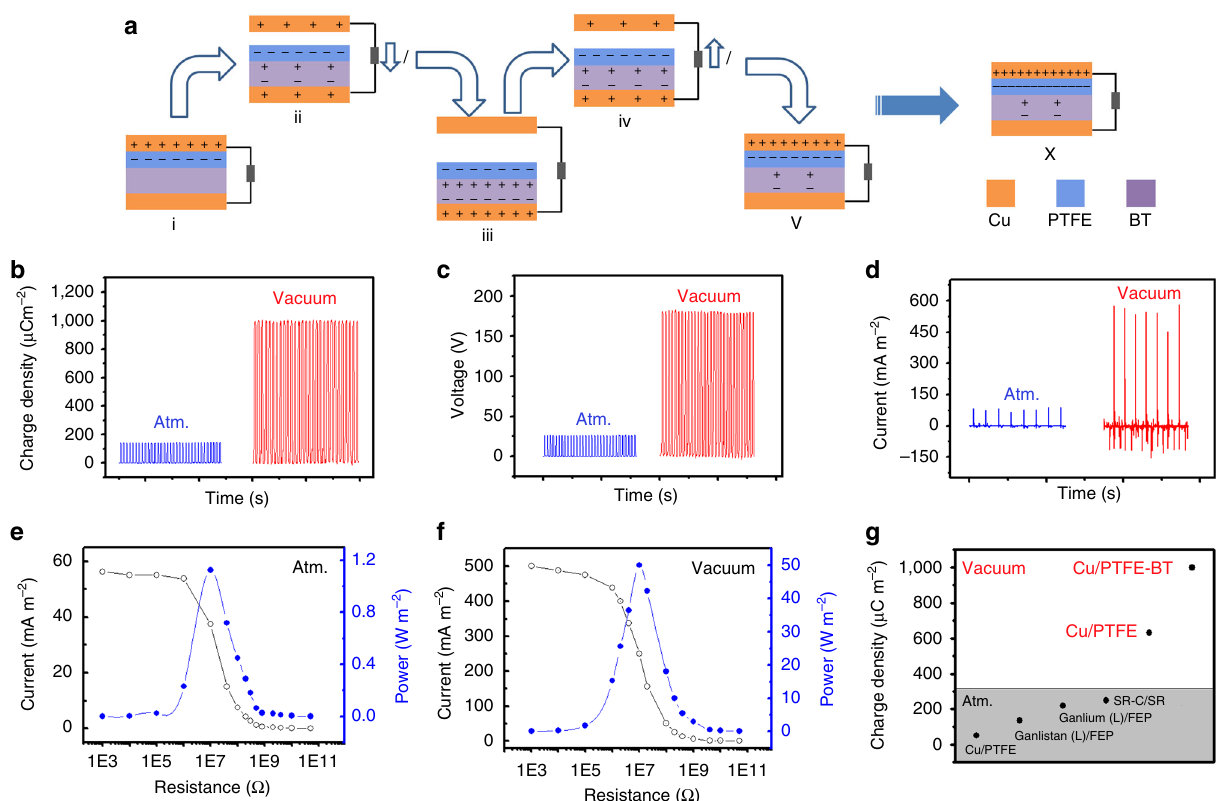
Fig. 3 Working mechanism and output performance of TENG with the coupling of surface and dielectric polarization. a Working mechanism of the TENG with the integration of triboelectric material PTFE with ferroelectric material BT. b Charge density, c open-circuit voltage, and d short-circuit current of the TENG in atmosphere and high vacuum. e , f Current density and power density of TENG with various loads at e atmosphere and f vacuum ( P ~ 10 − 6 torr). g Comparison of the output charges density measured in this work with previously reported